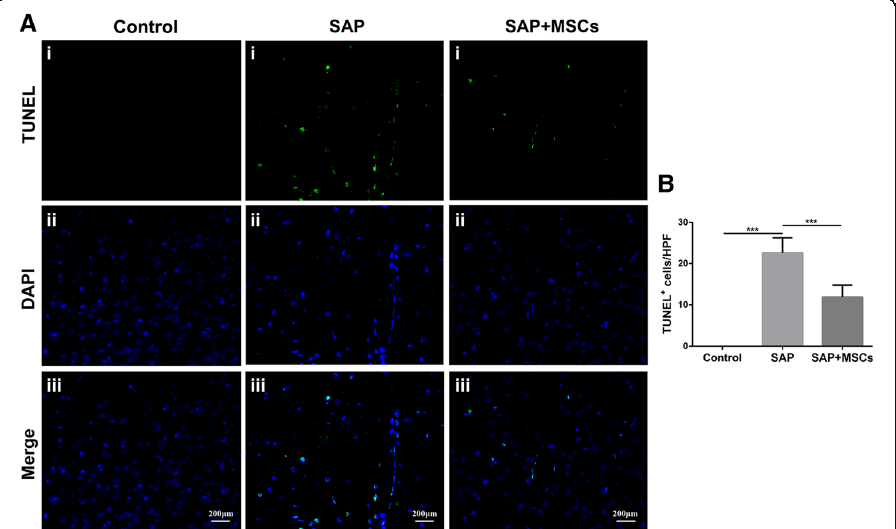
Fig. 5 MSCs reduced BMEC apoptosis in the brains of SAP rats . a TUNEL staining of the brain, scale bar = 200 μ m. No apoptosis was observed in the control group, but numerous apoptotic cells, mainly BMECs, were observed in the SAP group. Fewer apoptotic cells were observed in the SAP+MSCs group than in the SAP group. b Statistical analysis of TUNEL-positive cells. *** p <